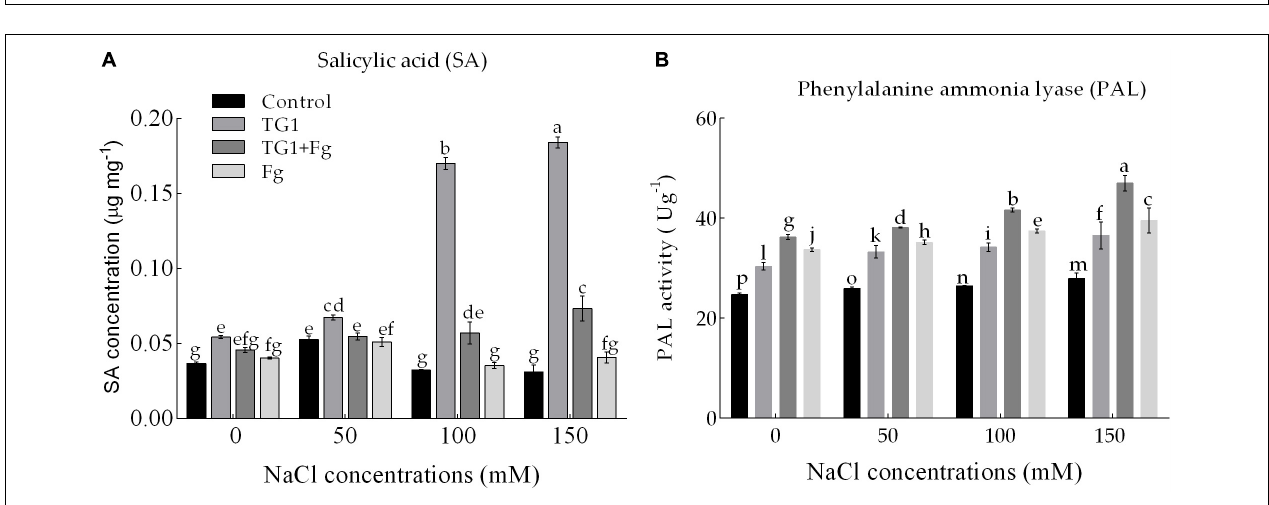
FIGURE 6 | Effect of T. longibrachiatum (TG1) on wheat seedling disease index at 28 days after inoculation under F. pseudograminearum (Fg) and different NaCl stress. Panels (A,B) represent treatments without NaCl; (C,D) represent treatments with 150 mM of NaCl stress; and (E) represents the disease index across the four NaCl concentrations (0, 50, 100, and 150 mM). Small bars represent the standard errors of the means. Different lower case letters indicate significant differences at P < 0.05 in Duncan’s multiple range test using two-way ANOVA. The treatments are detailed in the footnote of Figure 5 .